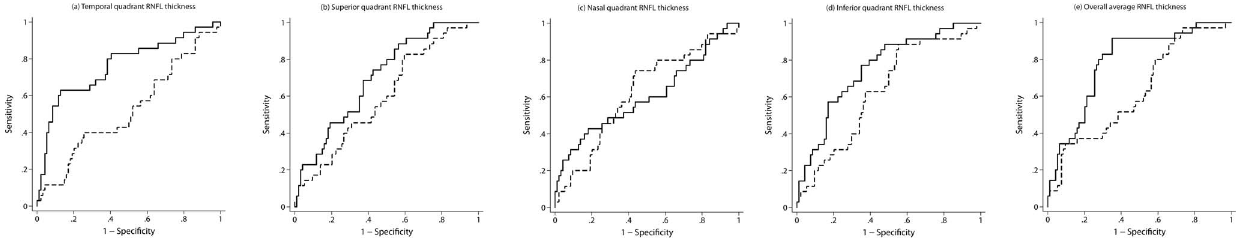
Figure 3. Receiver operating characteristic curves of the (a) temporal quadrant, (b) superior quadrant, (c) nasal quadrant, (d) inferior quadrant and (e) overall average retinal nerve fiber layer (RNFL) thickness parameters of spectral domain optical coherence tomography (solid line) and GDx enhanced corneal compensation (dashed line) in preperimetric glaucoma. doi:10.1371/journal.pone.0108992.g003 PLOS ONE |